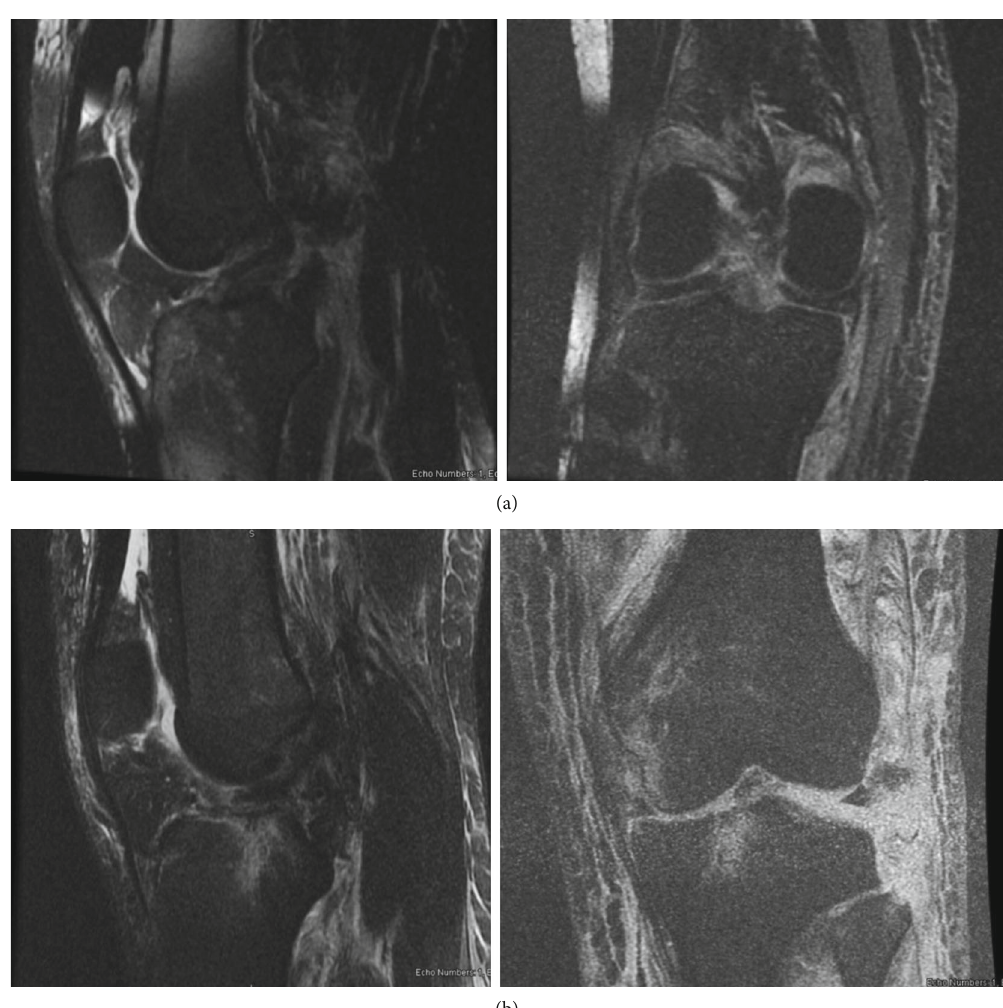
Figure 4: (a) MRI of the right knee depicting ACL and PCL rupture (left) and MCL rupture (right). (b) MRI of the left knee depicting ACL avulsion and PCL rupture (left) and LCL avulsion and PLC injury